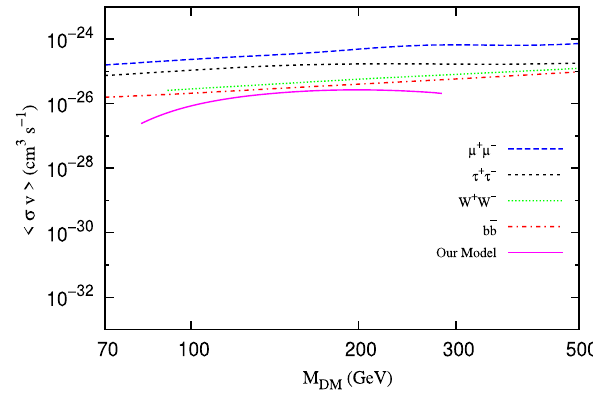
Fig. 3 Variation of thermally averaged annihilation cross-section with DMmasses.Themagentaandthedashedcurvesrepresentthevariations of (cid:9) σv (cid:10) for the model and various annihilation cross-sections predicted by combined results of FERMI-LAT and MAGIC experiments [87] respectively. Colour coding is expressed in legends